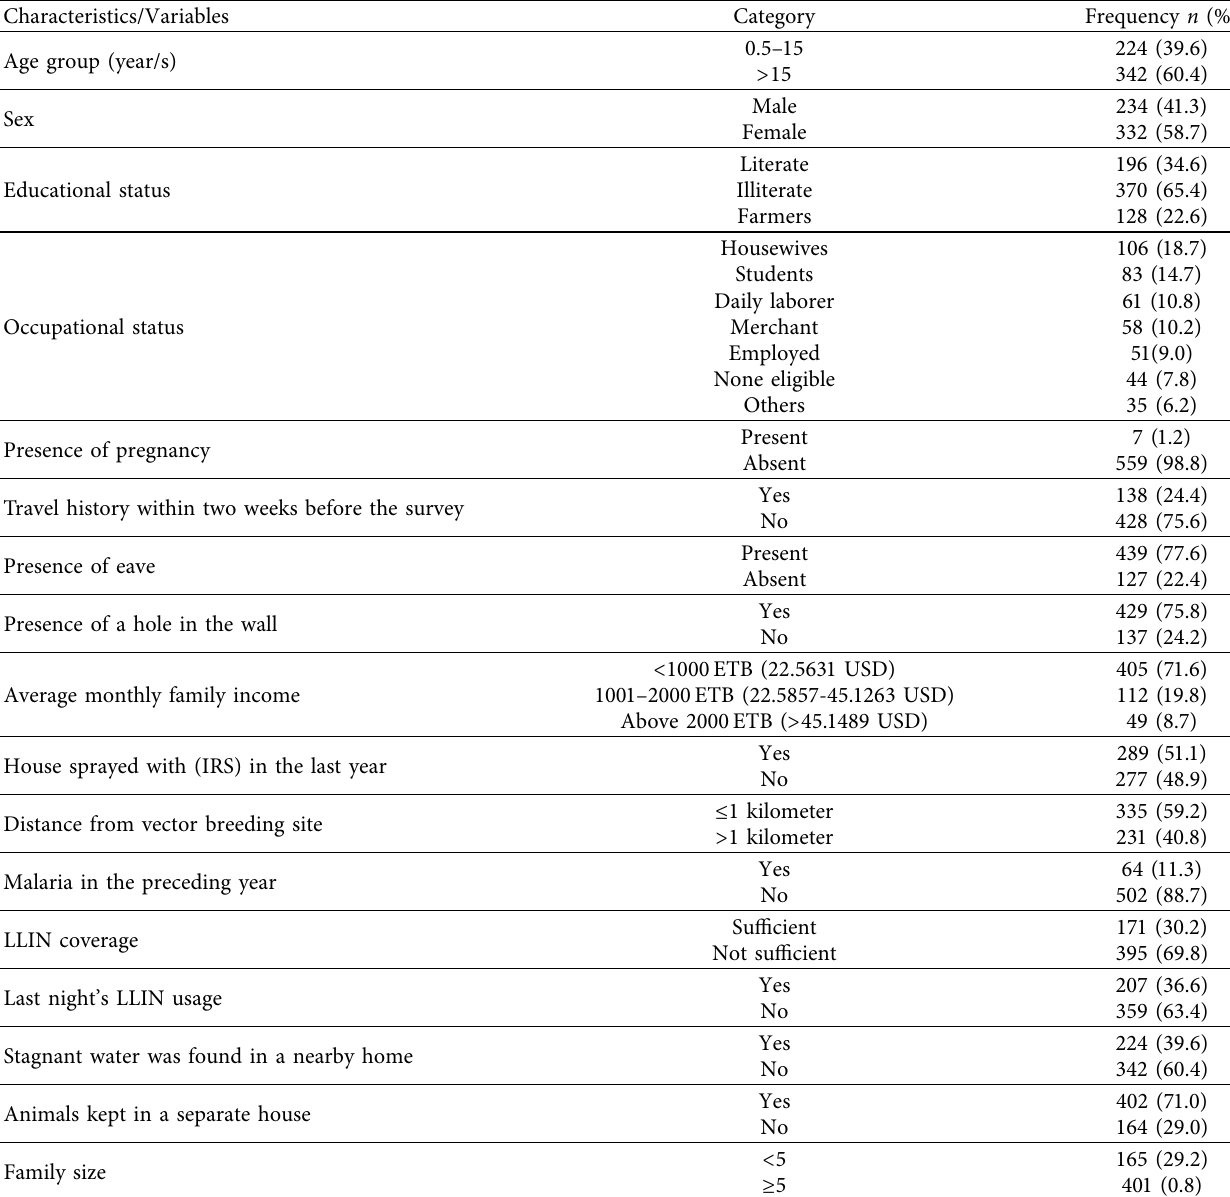
Table 1: Sociodemographic characteristics and associated factors of the study participants in selected districts of the Kafa zone, southwest Ethiopia ( n �